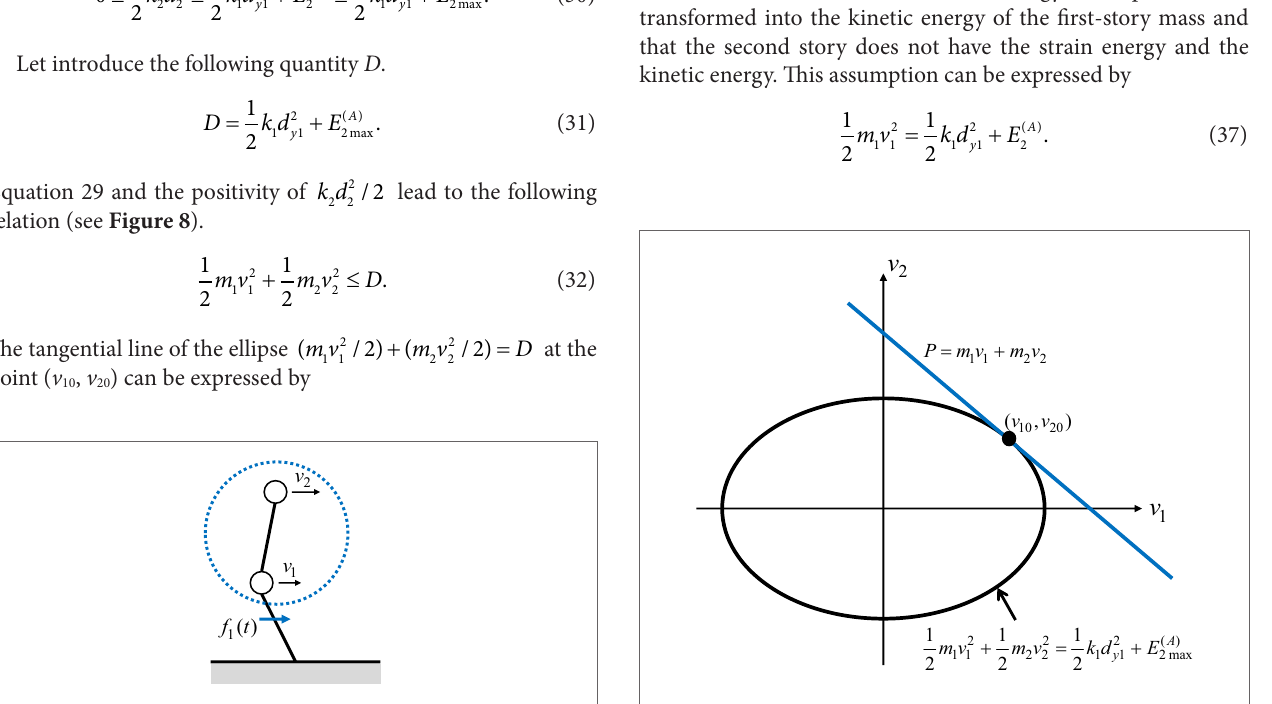
FigUre 7 | story shear force f 1 ( t ) in the first story and velocities of masses.